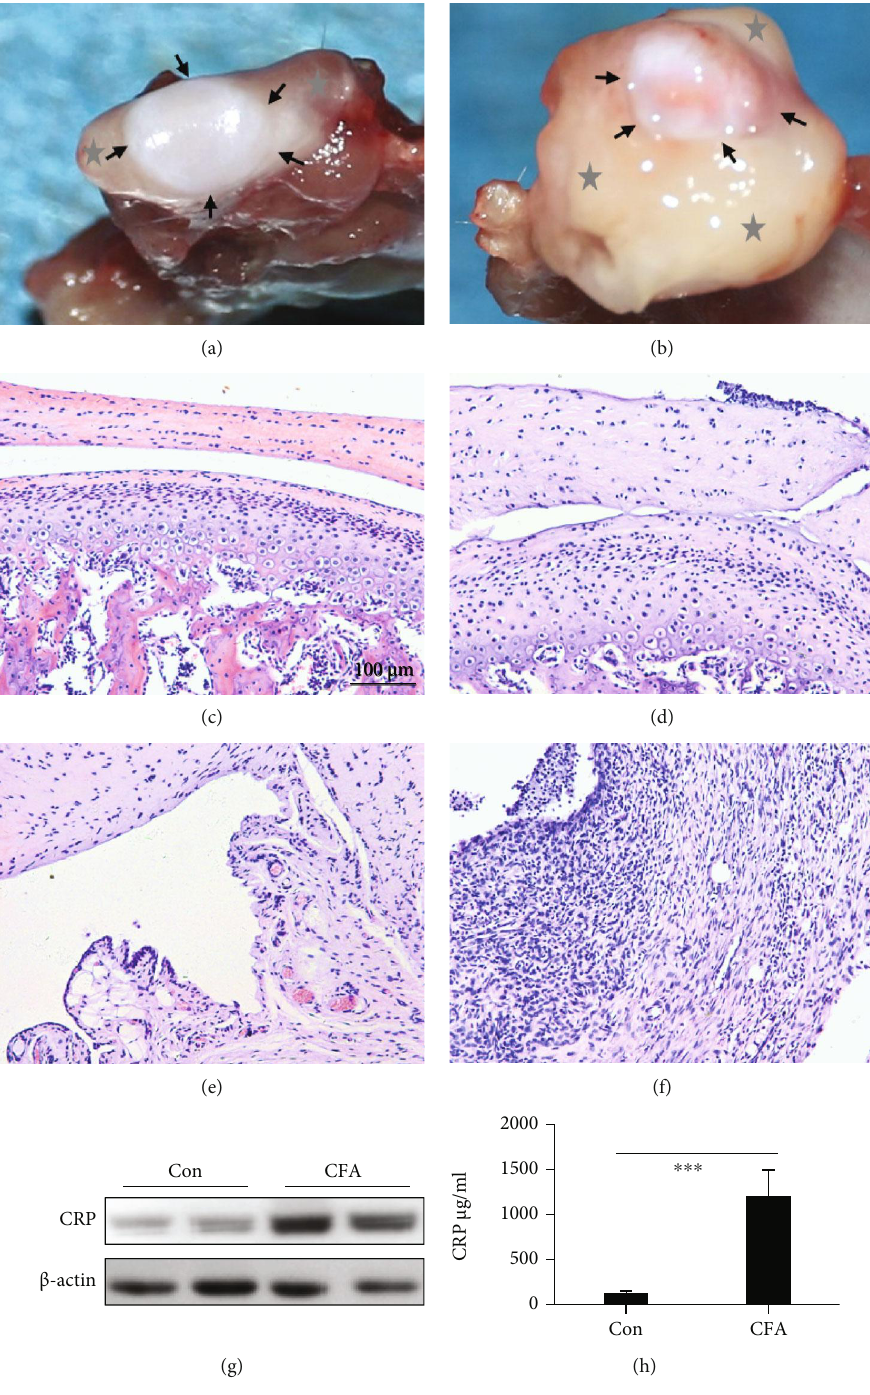
Figure 1: CFA induced TMJ in fl ammation with CRP overexpression. (a) and (b) Representative images of exposed TMJs and swollen and hyperplastic synovial membranes in the control and CFA groups, respectively. The part around with arrows is disc, and synovium is covered with grey stars. (c) and (d) Representative images of H&E-stained slides show the middle part of the TMJ disc and cartilage of control and CFA groups, respectively. (e) and (f) Images of H&E-stained slides showing synovial membranes from the anterior superior region of control and CFA groups, respectively. (g) CRP protein expression of hepatic tissue (each protein with 2 parallels). (h) Serum CRP level between control and CFA group ( N = 4 ; mean + SD ; ∗∗∗ p < 0 : 001